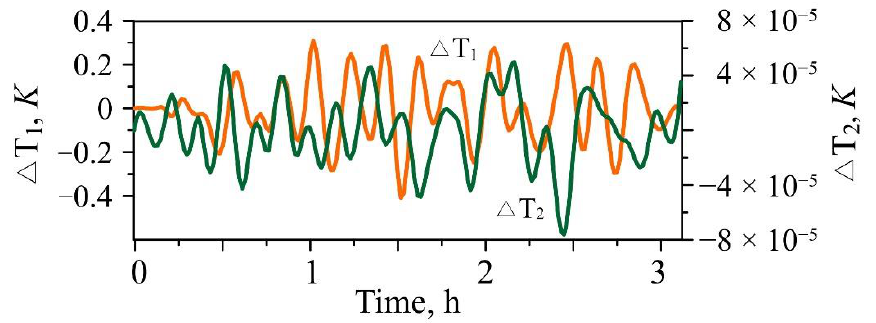
Figure 6. Temperature variations in the region of the tropospheric source (green line) and at an altitude of 300 km (orange line). The initial moment corresponds to the start time of calculations.